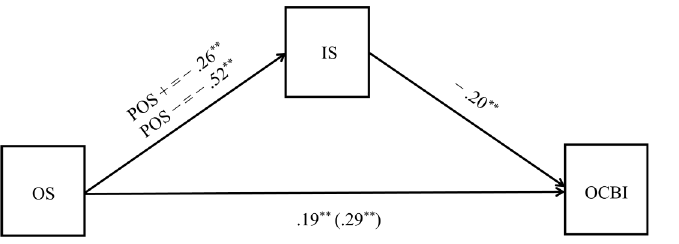
Fig 2. Results of the moderated mediation model. Note: (cid:3)(cid:3) p < .01 Legend: OS: Organizational socialization; POS: Positivity; IS: Interpersonal strain; OCBI; Organizational citizenship behaviors toward individuals.